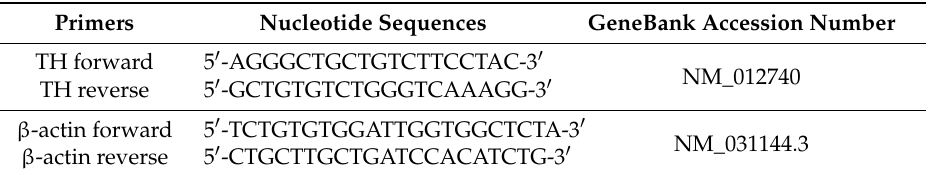
Table 5. Primers sequences used for real time